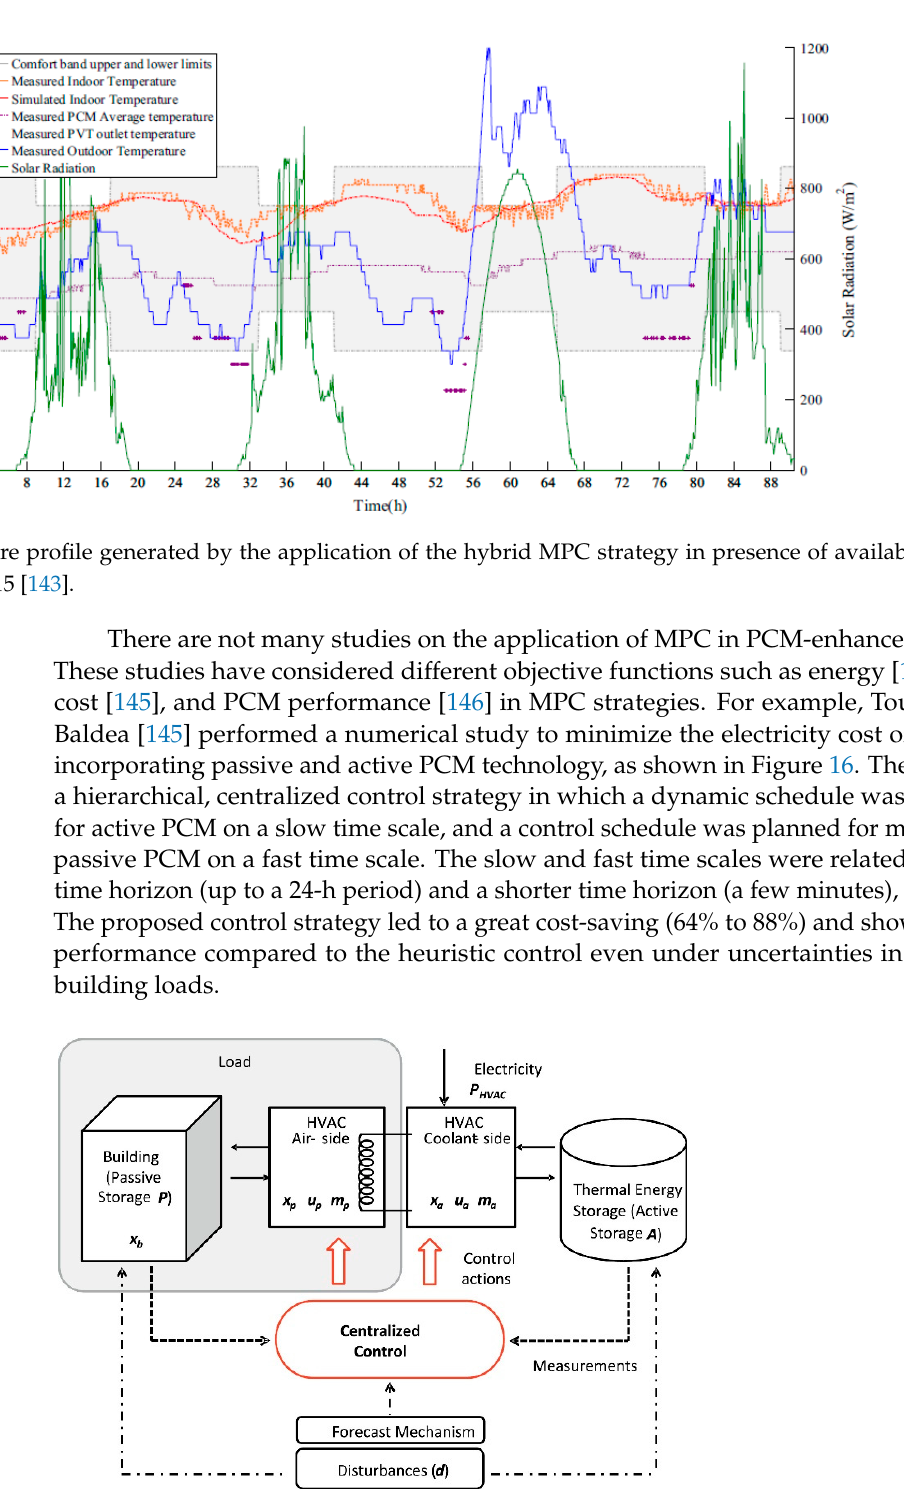
Figure 16. Centralized MPC strategy applied to PCM-enhanced building [145].